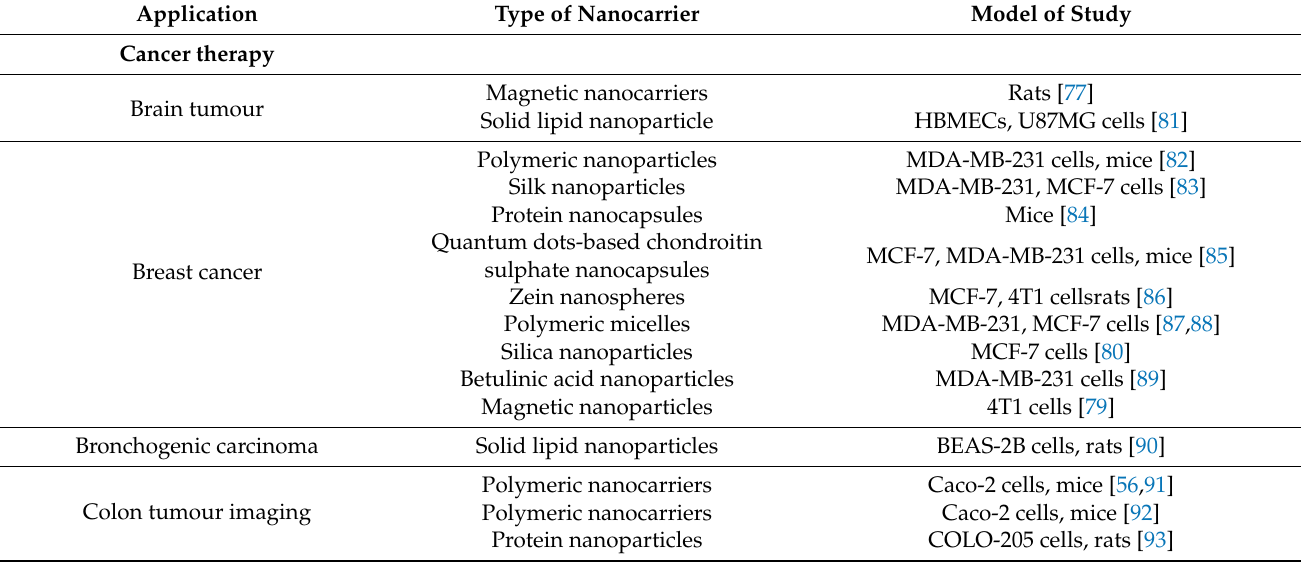
Table 1. Studies regarding the use of lactoferrin in different nanocarriers for therapeutic applications.